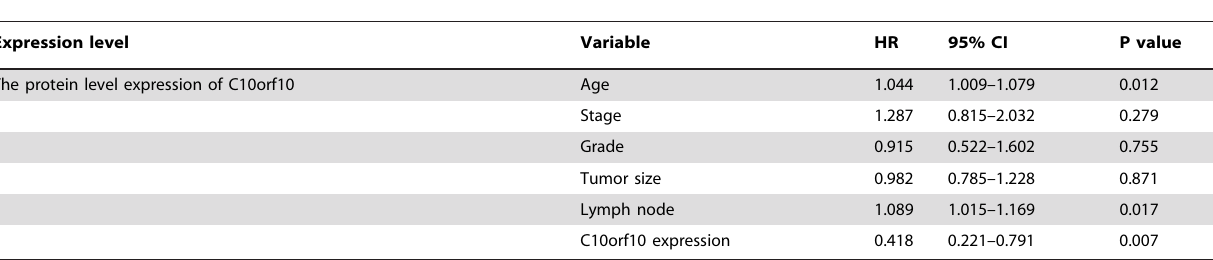
Table 1. Multivariate analysis of different prognostic factors in BC patients.